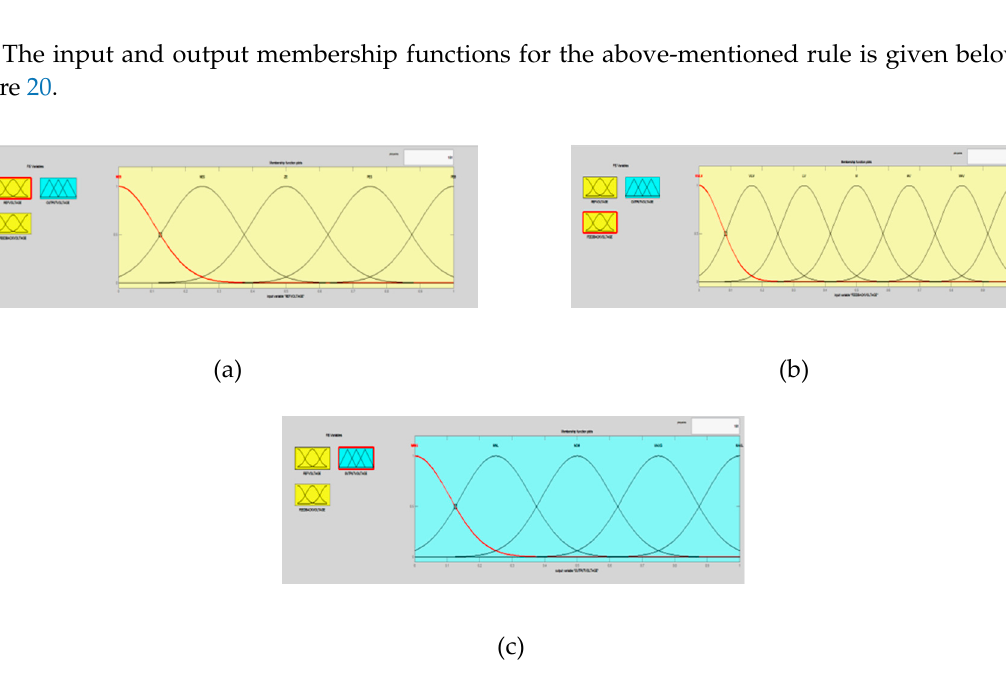
Figure 20. Membership Functions for Fuzzy sets: ( a ) Input 1(error); ( b ) input 2 (change in error); ( c ) output .